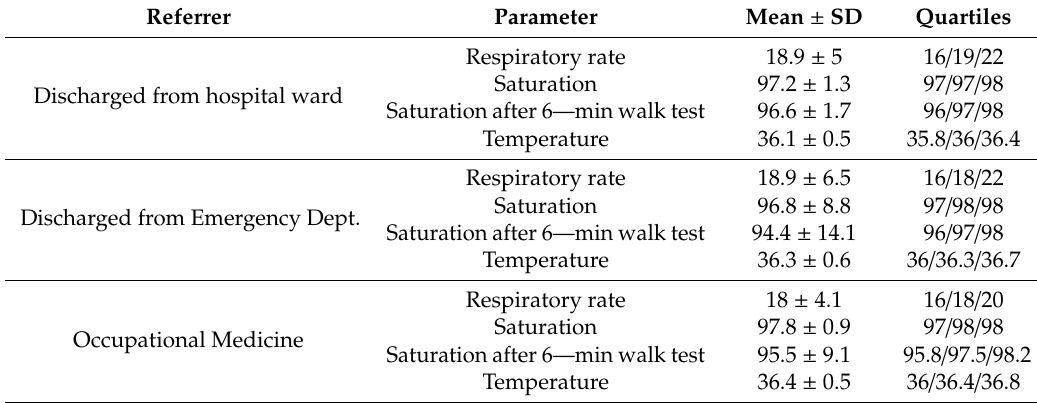
Table 1. Parameters on admission to the active home surveillance service.